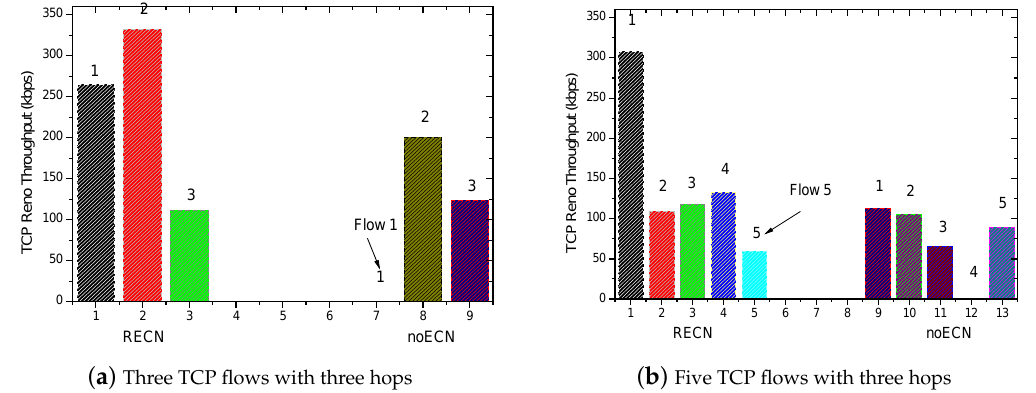
Figure 7. Comparison of fairness with three hops.